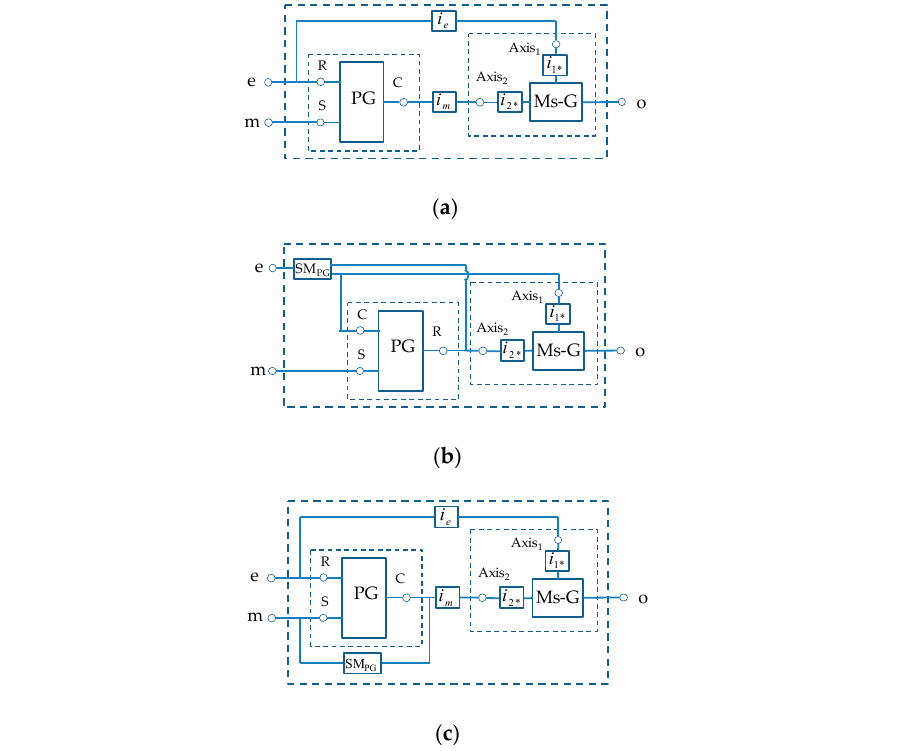
Class.—classification; No.—number; CL—clutch; I-a—input axis; P-p—power paths; Sy.— synchromesh; P-m—power merge.